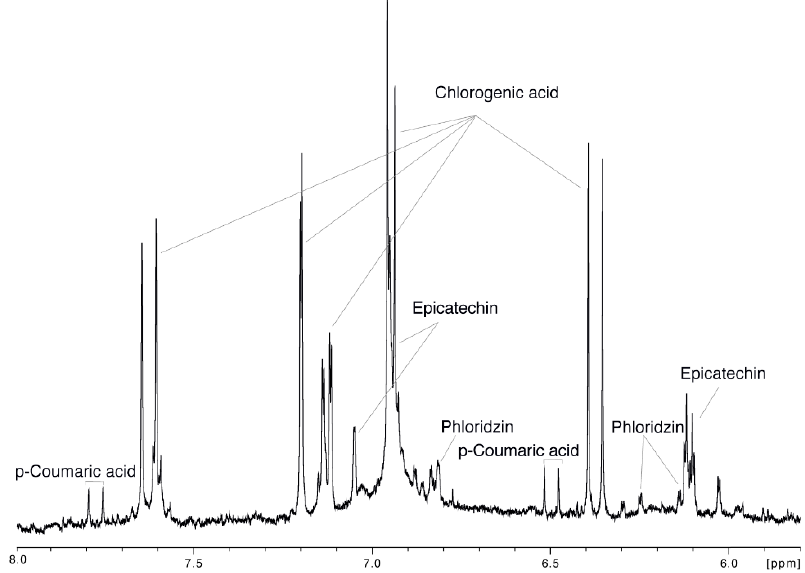
Figure 6. Aromatic region and relative signal assignment of a representative 1 H-NMR (nuclear magnetic resonance ) spectrum of apple juice.